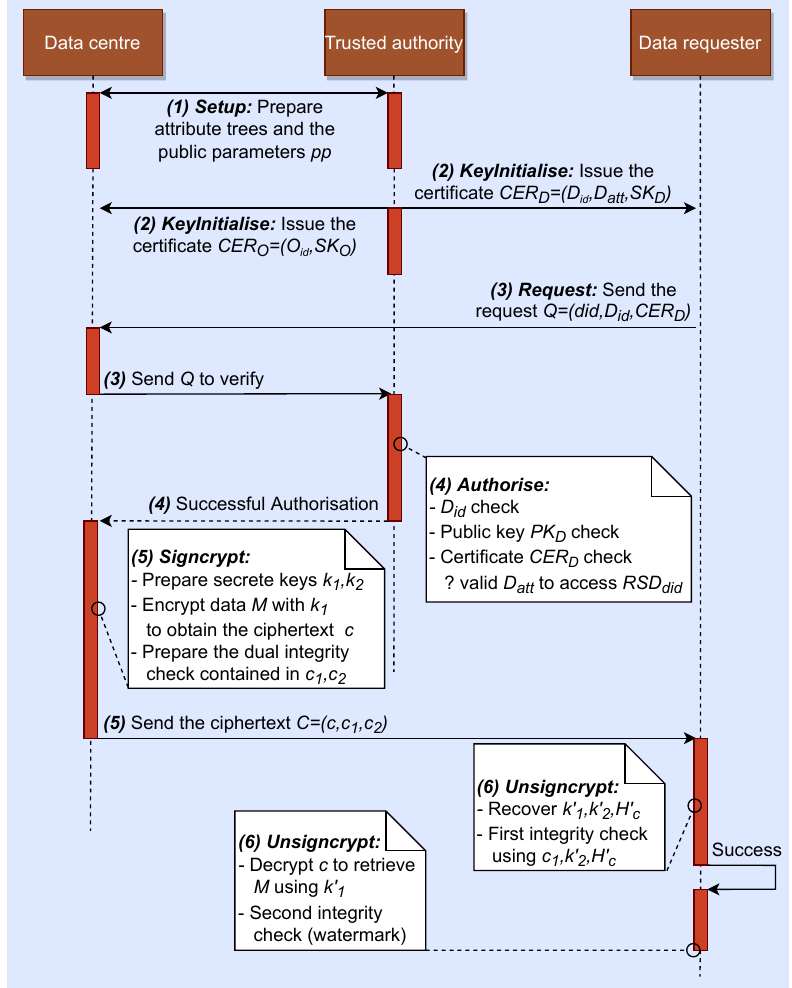
Figure 3. The workflow of